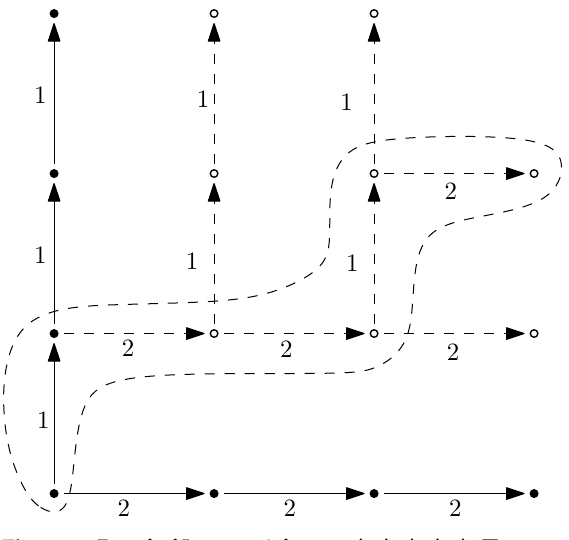
Figure 4. Proof of Lemma 8 for t = ♦ 1 ♦ 2 ♦ 2 ♦ 1 ♦ 2 (cid:62)